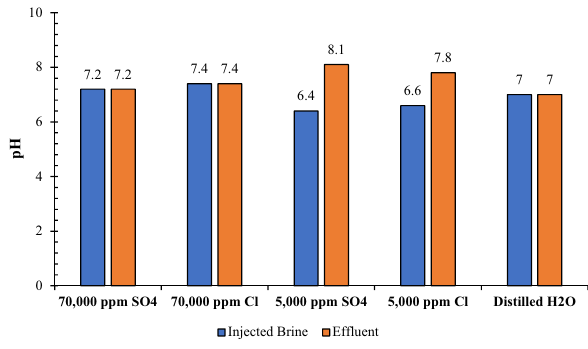
Fig. 15 pH profiles of injected brines and their corresponding efflu-